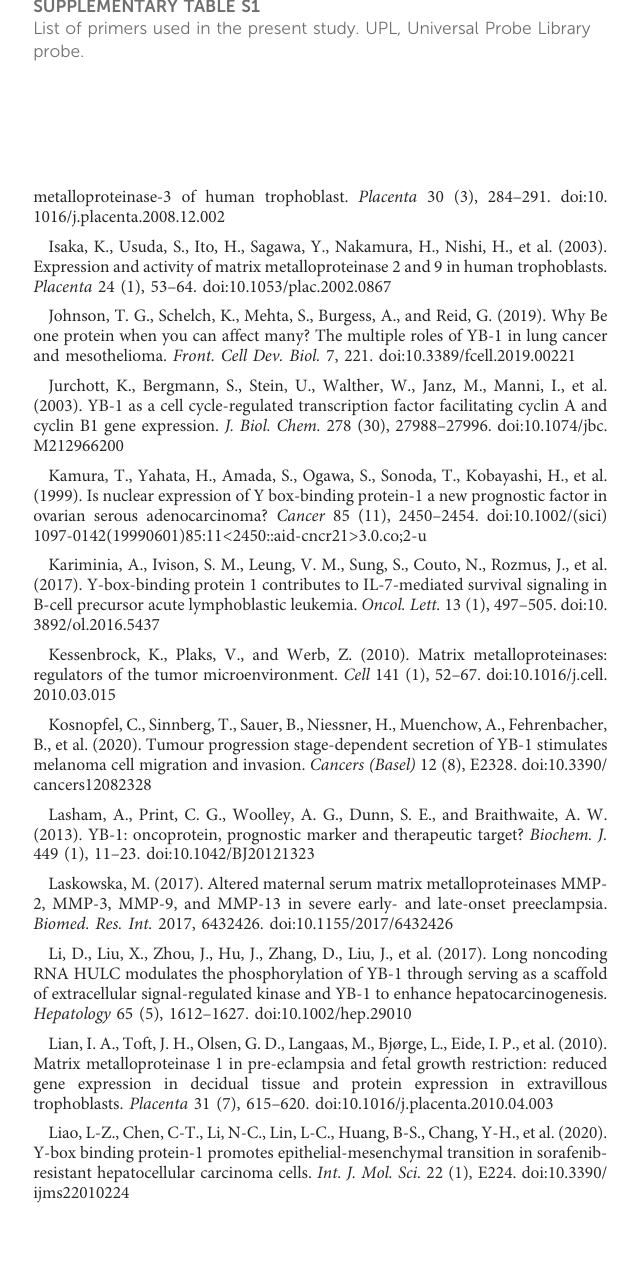
SUPPLEMENTARY FIGURE S1 Transcriptional analysis of genes related to proliferation, immune response, angiogenesis and invasion in YB-1 de fi cient mice. The expression of indicated genes was measured by RT-PCR in uterine/ decidual tissue of heterozygous YB-1 and wildtype mice at GD14. Shown is the fold-expression of the heterozygous YB-1 mice in comparison to the wildtype group according to ddCt method. n = 4. Egfr , epidermal growth factor receptor; Notch1 , neurogenic locus notch homolog